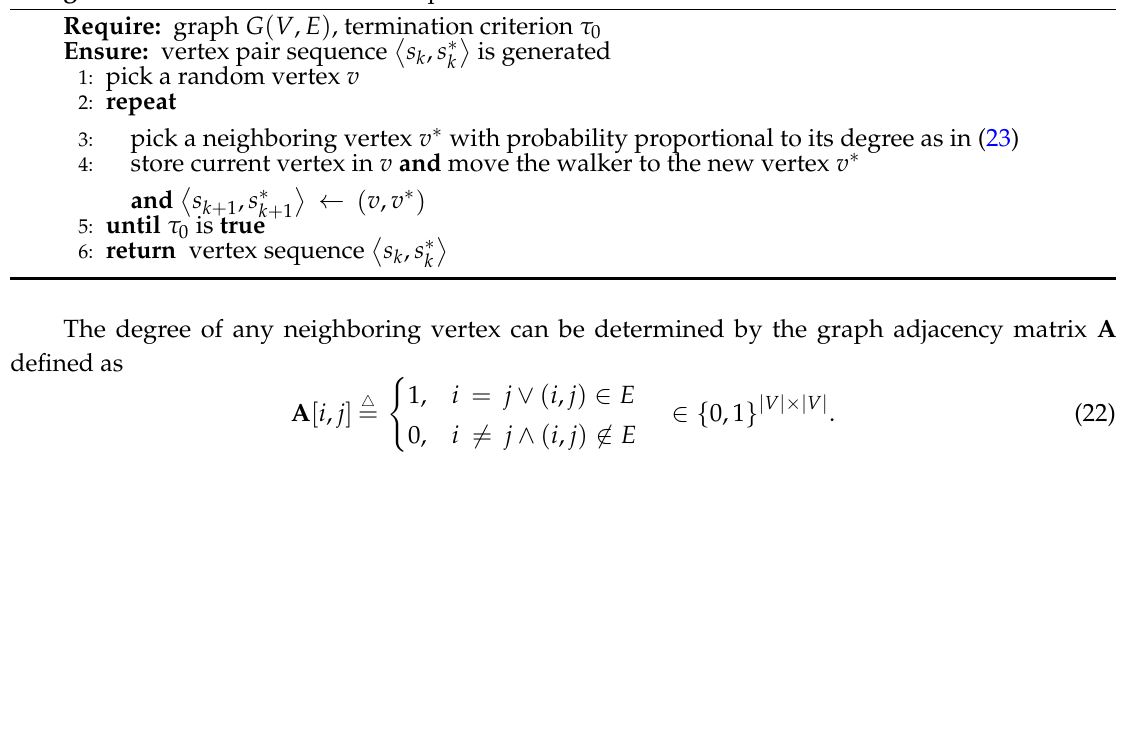
Algorithm 1: Deterministic